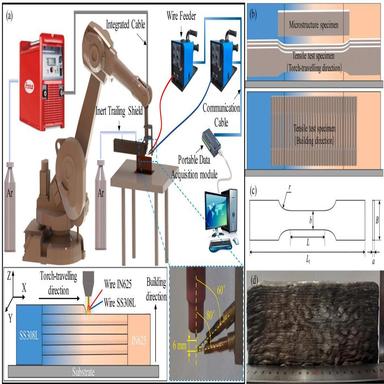
Experimental setup, and the preparations of FGM specimens and tensile samples. (a) D-WAAM system, schematic diagram for the preparation of FGMs and arrangement of the torch and two wires, (b) locations of the tensile test samples, (c) dimensions for the tensile test samples, (d) the appearance of typical FGM specimen (Specimen #2).